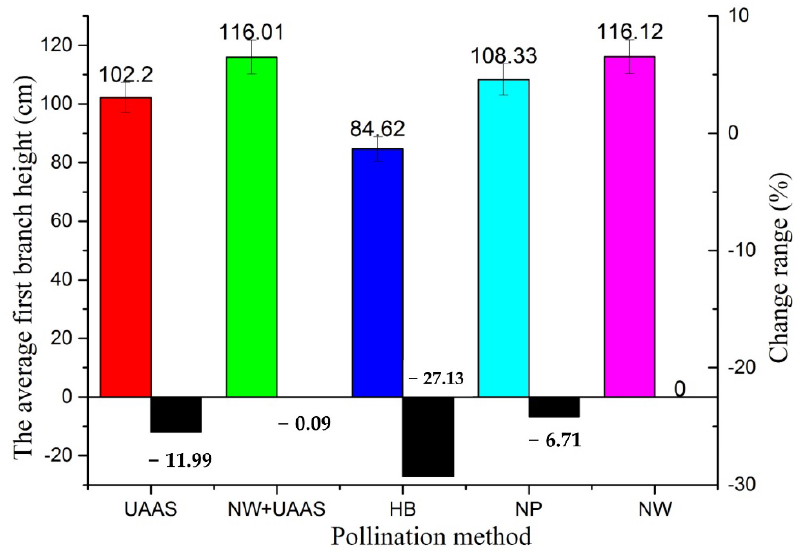
Figure 6. The AFBHs of different pollination areas and AFBH change ranges. Note: UAAS—un- manned agricultural aerial system; NW+UAAS—natural wind + UAAS; HB—honeybee; NP—no agricultural aerial system; NW+UAAS—natural wind + UAAS; HB—honeybee; NP—no pollinators; pollinators; NW—natural wind; AFBH—average first branch height. NW—natural wind; AFBH—average first branch height.